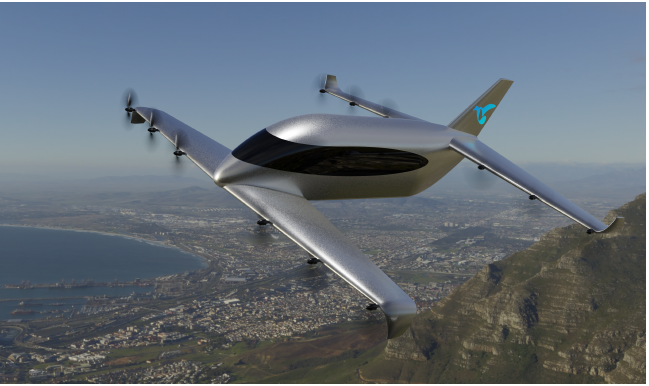
Figure 1. Rendering of the final design of the analysed configuration of the